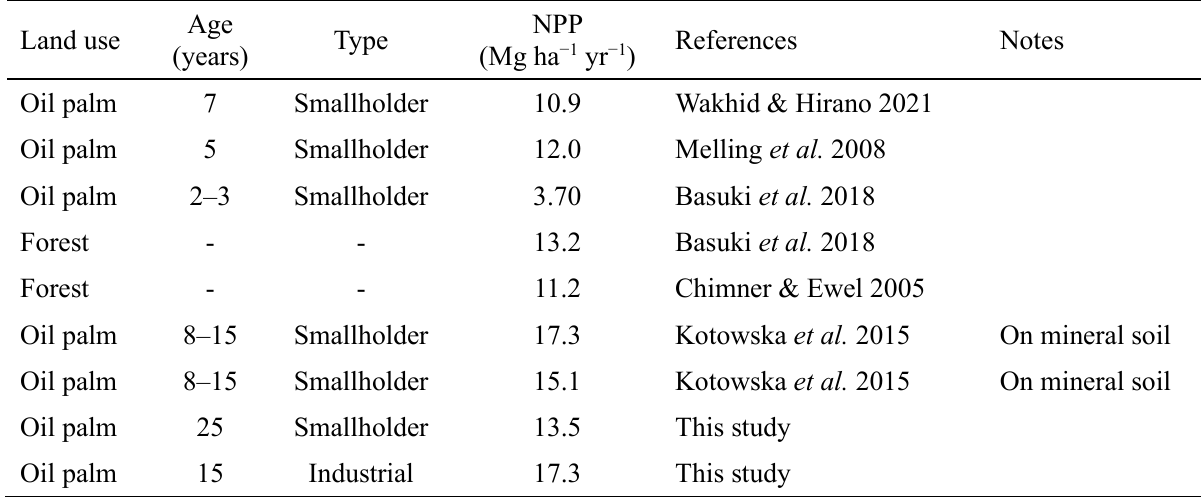
Table 8. Comparison of Net Primary Production (NPP as C) with previous studies on peat and mineral soil. Land